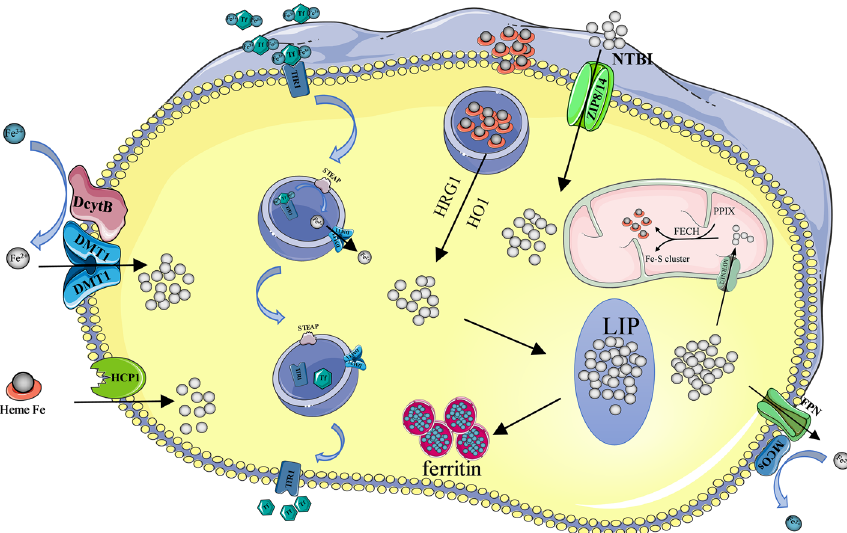
Fig. 1 Iron metabolism in normal cells. Ferric iron in food is reduced to Fe 2+ by DcytB and then taken up by DMT1 into the intestinal epithe- lium. HCP1 mediates the absorption of heme iron by intestinal cells. Fe-Tf-TfR1 complexes enter the cell by endocytosis, forming the endo- some, where Fe 3+ is reduced to Fe 2+ by the STEAP. Then, Fe 2+ is transported from the endosome to the cytoplasm via DMT1, and the Tf-TfR1 complex immediately returns to the cell membrane for the next cycle of transport. The figure also shows the pathway of circulating heme and NTBI into cells. DcytB duodenal cytochrome B, DMT1 divalent metal transporter 1, HCP1 Haem carrier protein 1, LIP Labile iron pool,